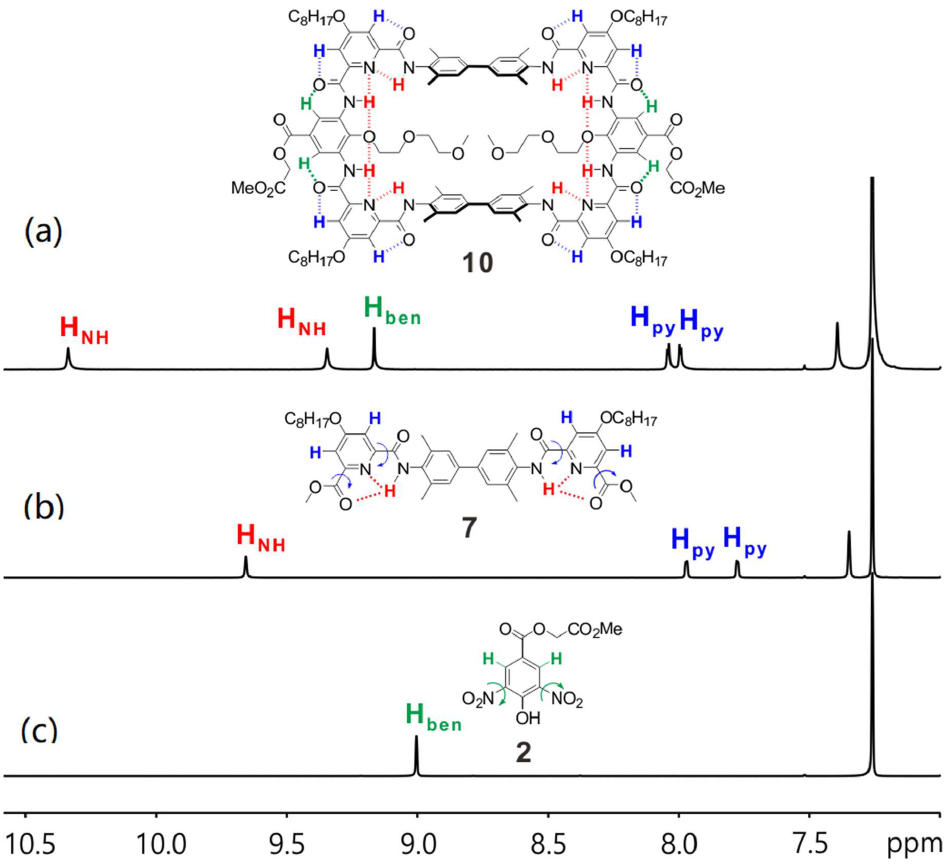
Figure 3. The amide and aromatic region of 1 H NMR spectra of ( a ) 10 , ( b ) 7 and ( c ) 2 in CDCl 3 at 298